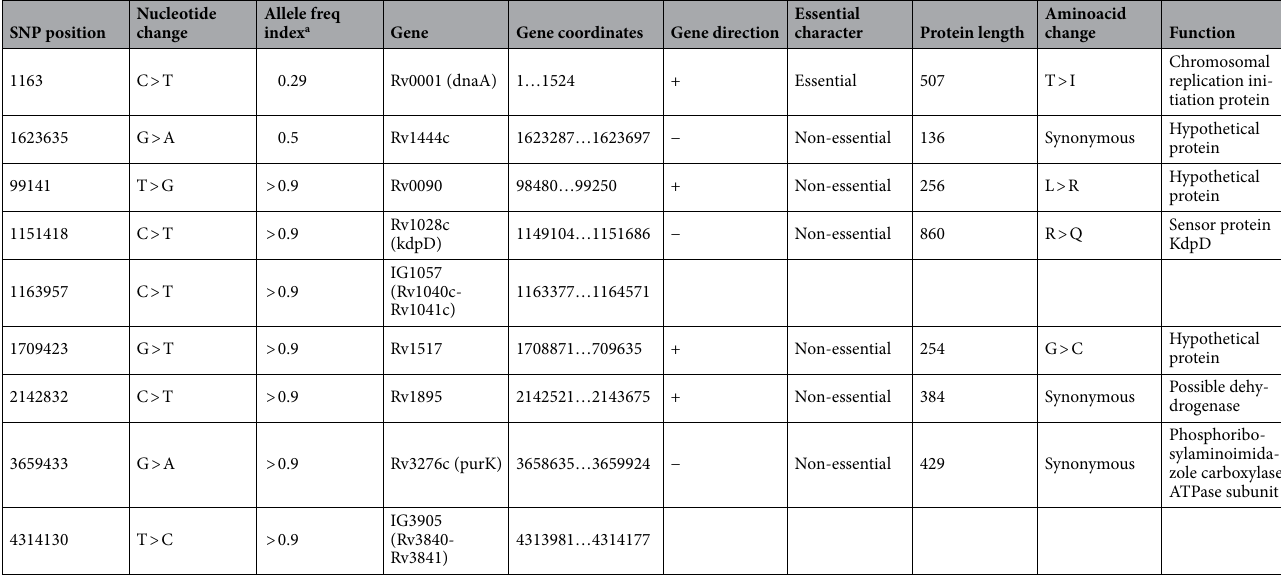
Table 1. Specific SNP annotation for the successfully transmitted Cluster 113 variant. a Allele frequency in all secondary cases was >